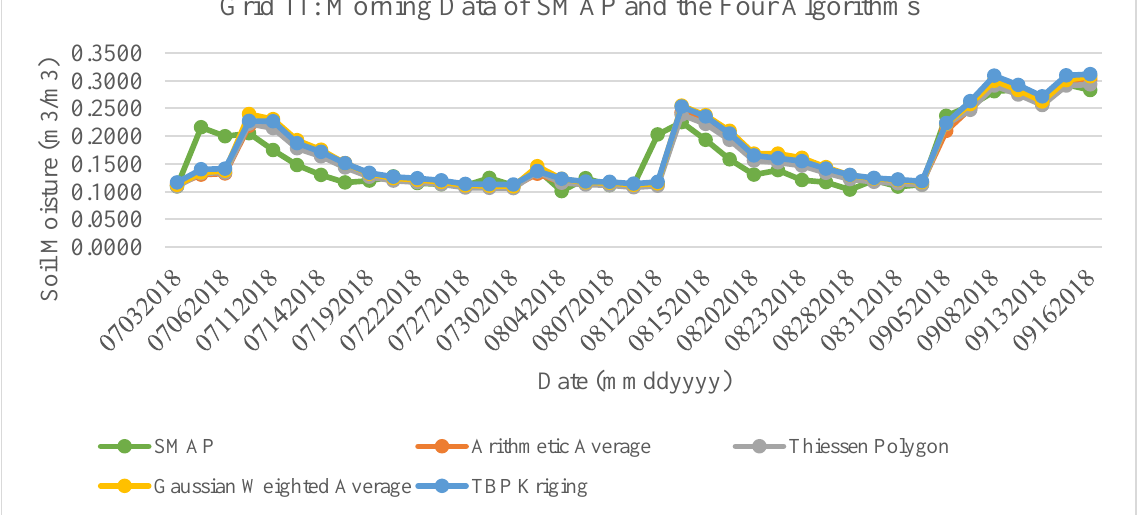
Figure 10. Grid 11 — spatial autocorrelation not detected: morning soil moisture data plot with SMAP and the four algorithms. Soil moisture was measured at 5 cm depth.